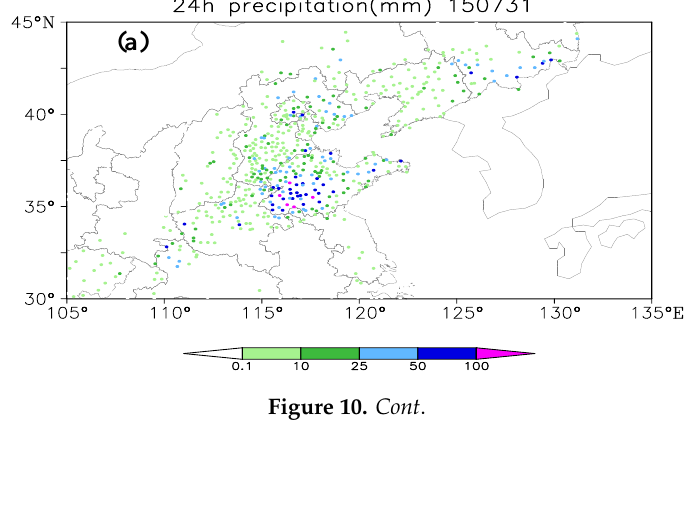
Figure 9. The verification of ensemble forecast of ETKF and ETKF-SS, ( a )–( c ), the time-series of rmse and spread of U200 hPa, T850 hPa, and U850 hPa, respectively; ( d )–( f ), the time-series of CRPS of U200 hPa, T850 hPa, and U850 hPa, respectively; ( g )–( i ), the time-series of outlier of U200 hPa, T850 hPa, and U850 hPa,